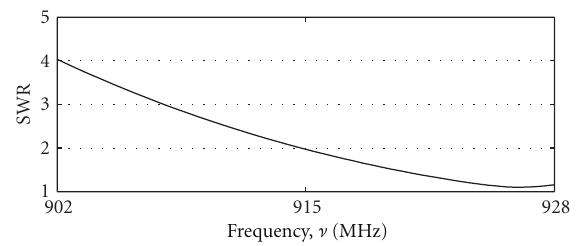
Figure 3: Optimal standing wave ratio behavior inside frequency range for worst case